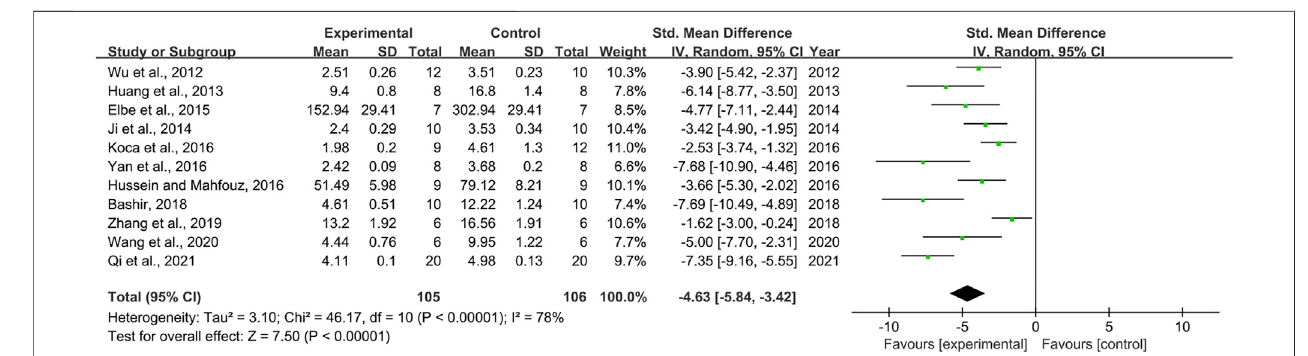
FIGURE 6 | Pooled estimate of MDA with